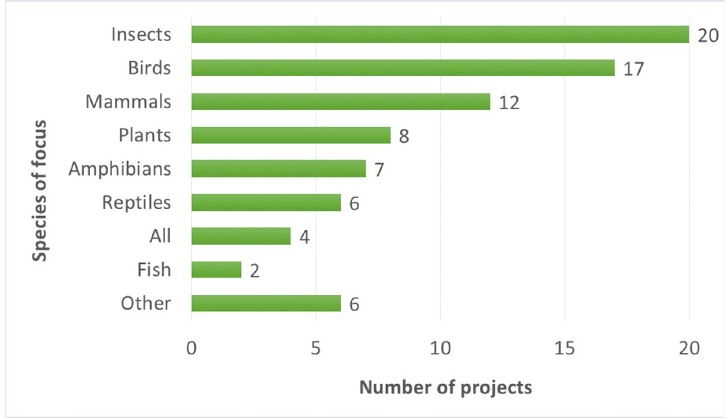
Fig 4. Species or organisms that are the focus of the participating projects (multiple answers